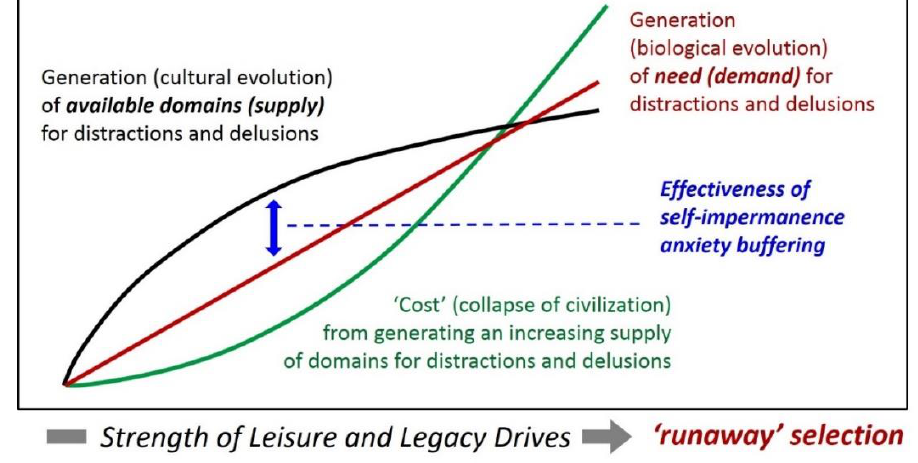
Figure 1. Effectiveness of self-impermanence anxiety buffering requires that available supply of domains for distractions and delusions (black line) is able to keep up with the increasing need (demand) for distractions and delusions (red line) generated by ‘runaway’ selection for more acute self-impermanence anxiety, and hence for stronger and stronger impulses for ‘escape from self’ (Leisure Drive) and ‘extension of self’ (Legacy Drive). Civilization therefore races faster and faster toward collapse (green line), because of the escalating negative impact on ecosystem services resulting from the escalating cultural evolution of products and institutions designed for delivering distractions and